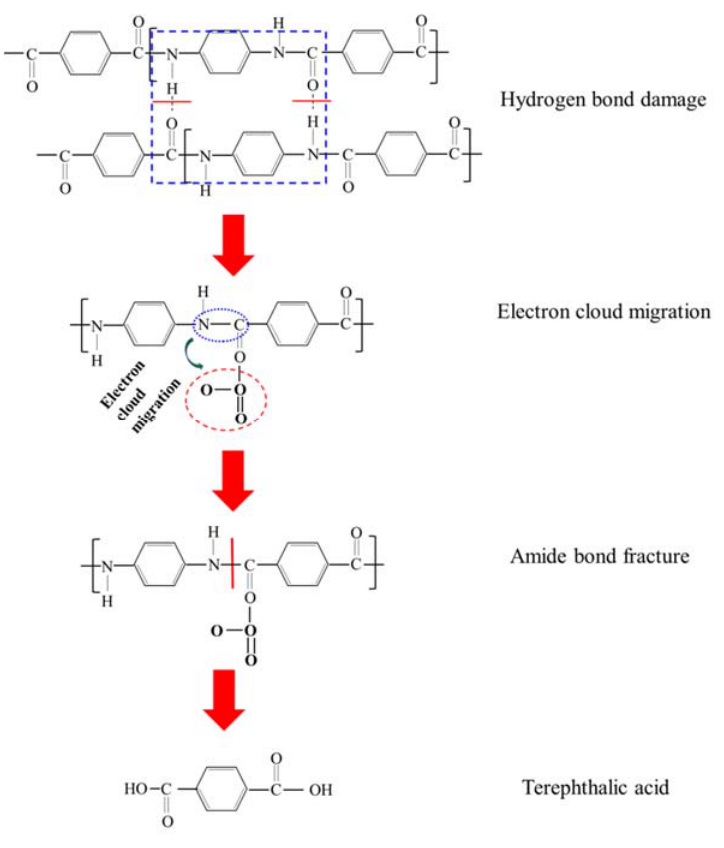
Figure 11. The reaction mechanism of Kevlar fiber in an ozone environment.